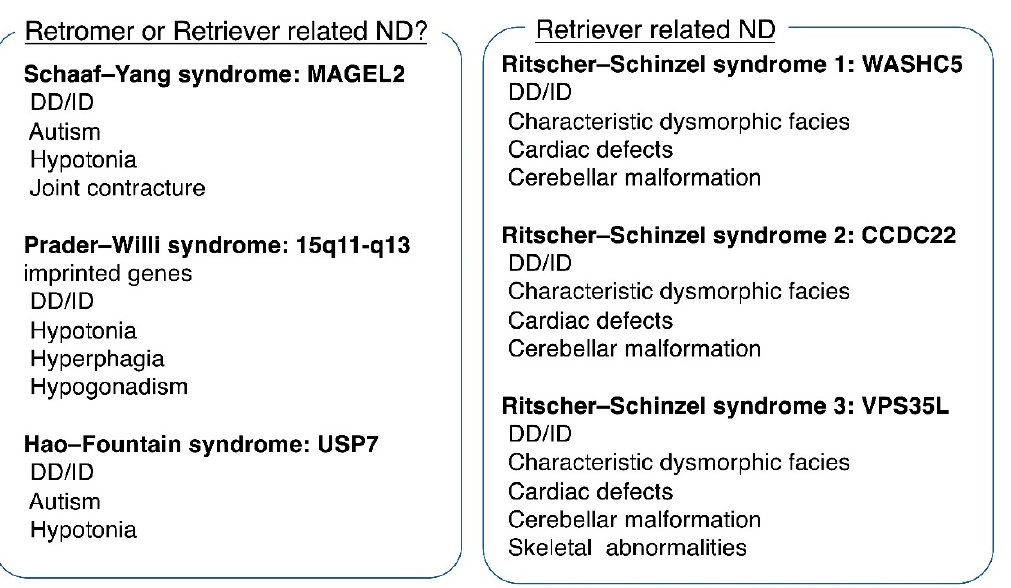
Figure 2. Putative neurodevelopmental disorders associated with retromer and retriever complexes. Major clinical features are demonstrated for each disorder. ND, neurodevelopmental disorder; DD, developmental delay; ID, intellectual disability.